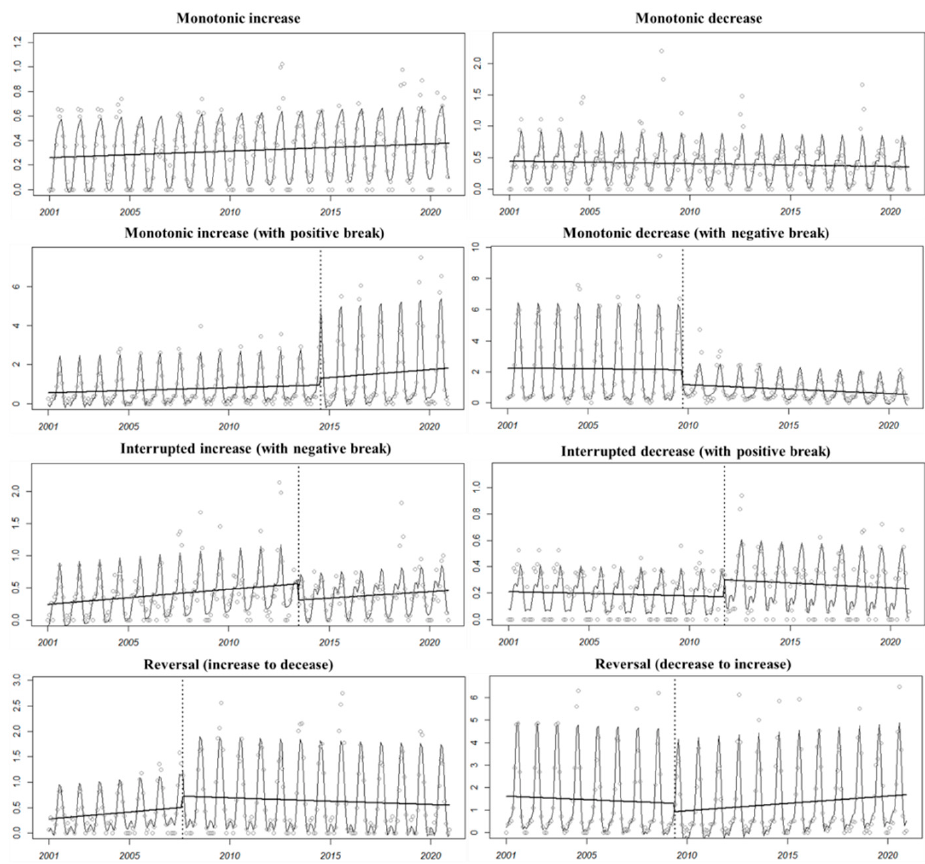
Figure 3. Examples of trend types: type 1, monotonic increase; type 2, monotonic decrease; type 3, monotonic increase (with positive break); type 4, monotonic decrease (with negative break); type 5, interrupted increase (with negative break); type 6, interrupted decrease (with positive break); type 7, reversal: increase to decrease; type 8, reversal: decrease to increase.